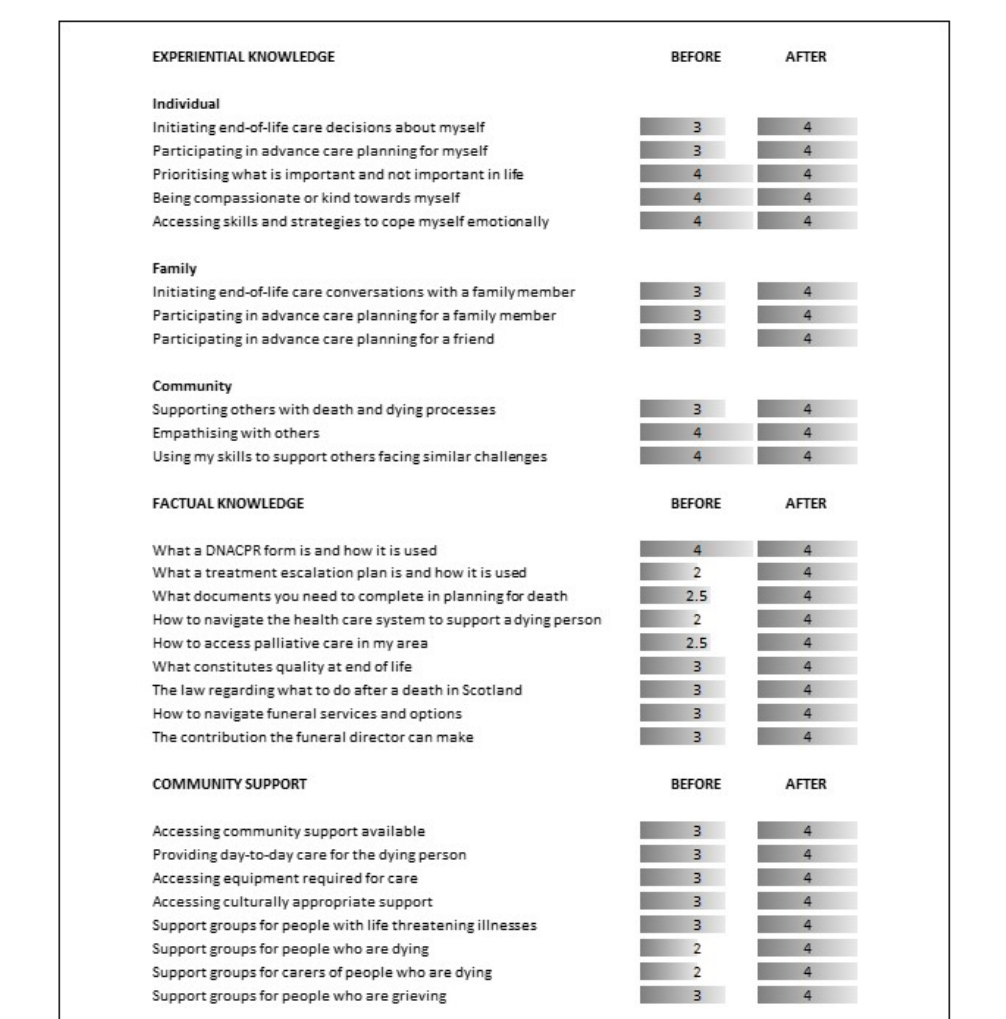
Figure 3. Experiential Knowledge, Factual Knowledge, and Knowledge of Community Support.